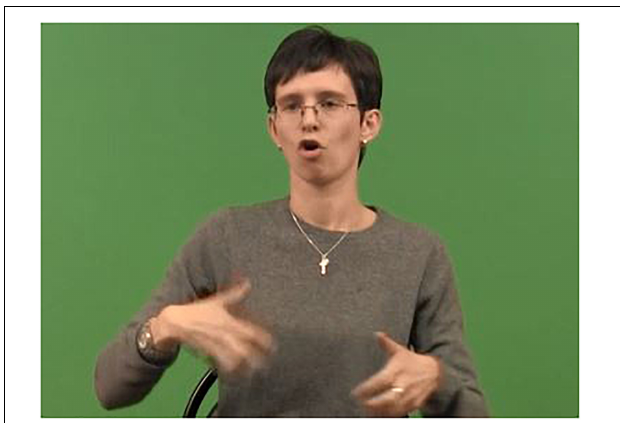
FIGURE 10 | RSL sign monkey. Reproduced with permission from Svetlana Burkova (Novosibirsk State Technical University), available at the online corpus of Russian Sign Language,